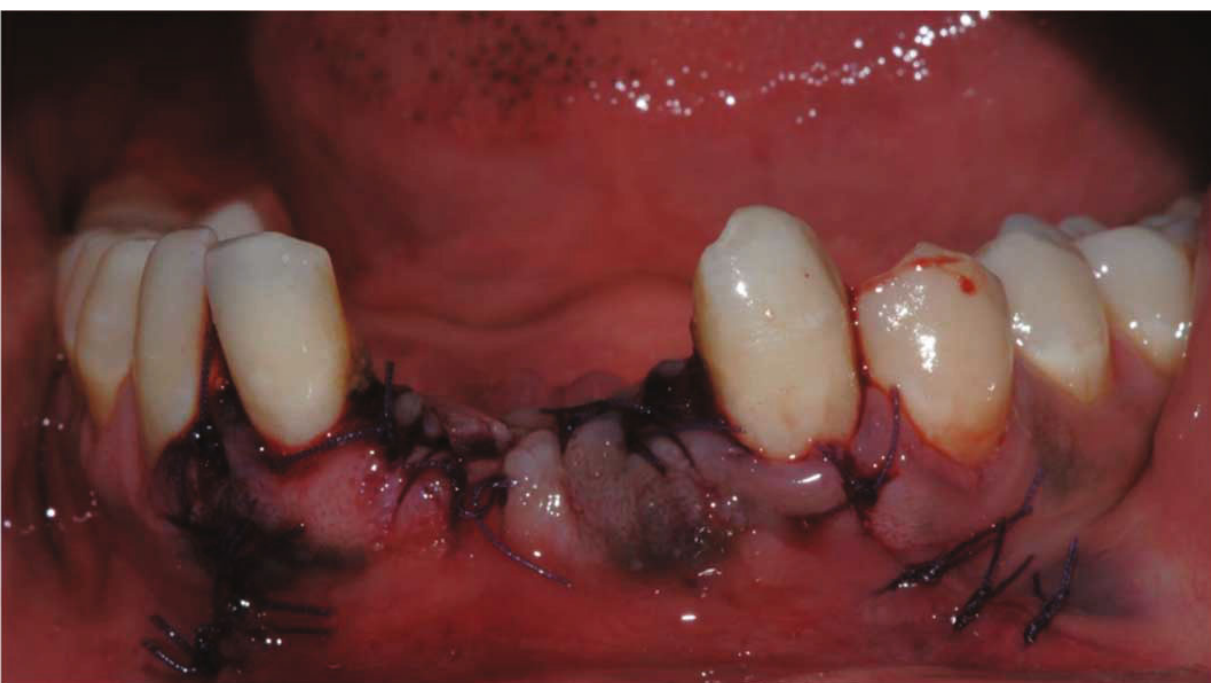
Figure 4: Clinical image immediately after the